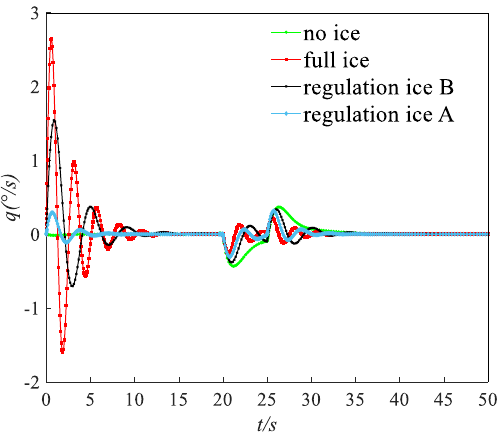
Figure 21. Dynamic response of pitching angular